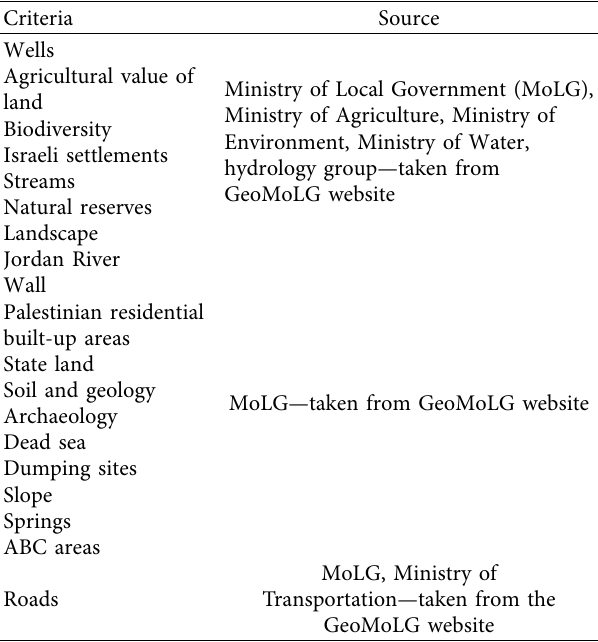
Table 3: Criteria GIS shapefiles